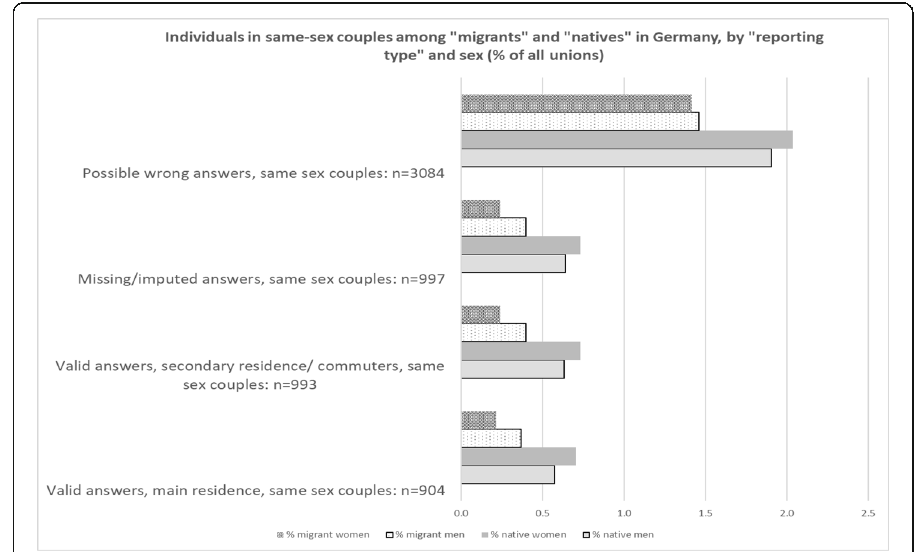
Fig. 1 Source: Illustrations based on German Micro census SUF 2013